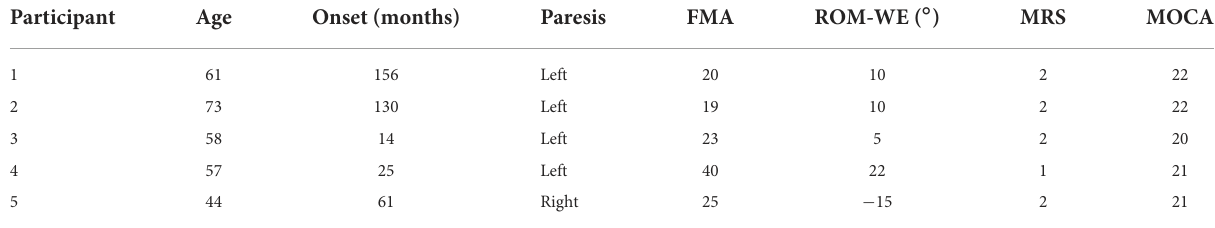
TABLE 1 Participant demographics and baseline evaluations.